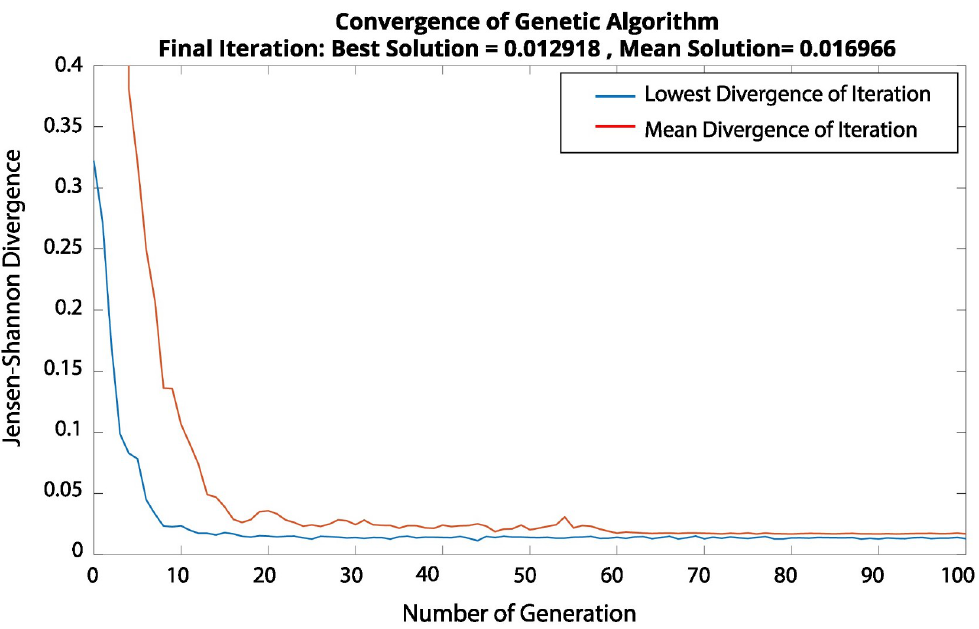
Fig 6. Convergence of the Genetic Algorithm. The genetic algorithm employed for optimization of the parameters of the floret-generator. Both the mean as well as the lowest Jensen-Shannon divergences associated with each generation of the genetic algorithm converge quickly to a stable value. The genetic algorithm halts if the maximal number of generations, by default set to ten times the number of parameters, is reached, or, if the weighted average change over 50 generations falls below 10 − 6